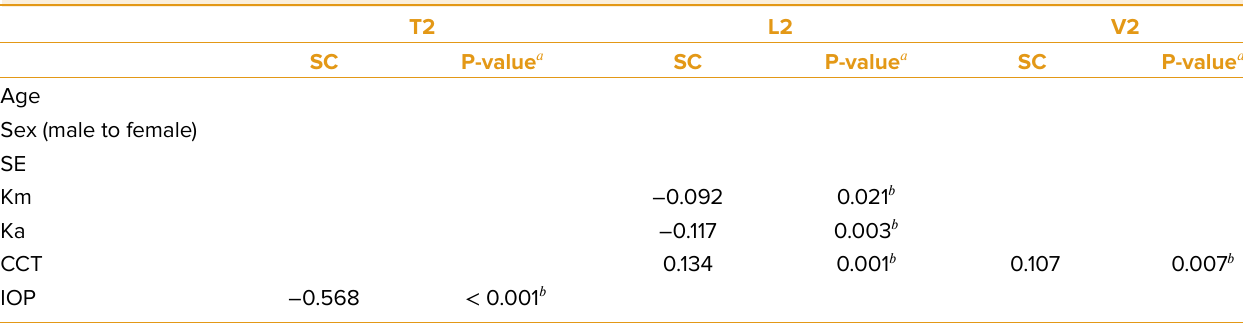
Table 4. Linear regression analysis demonstrating association between selected demographic and ocular factors to each Corvis ST parameters at the second applanation moment